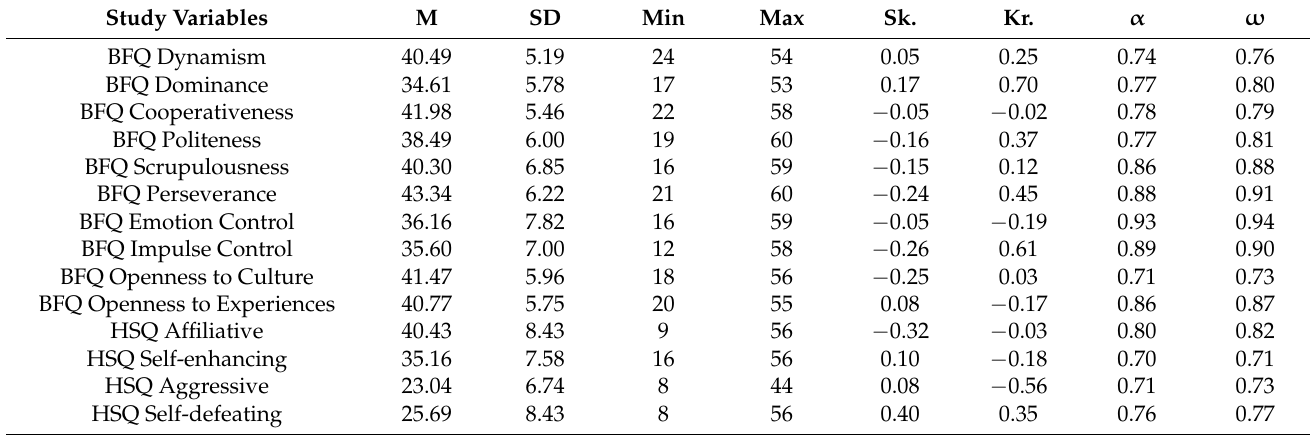
Table 1. Humor Styles Questionnaire and Big Five Questionnaire: Means, Standard Deviations, Skewness, and Kurtosis, Cronbach’s alpha, and McDonald’s Omega ( n =